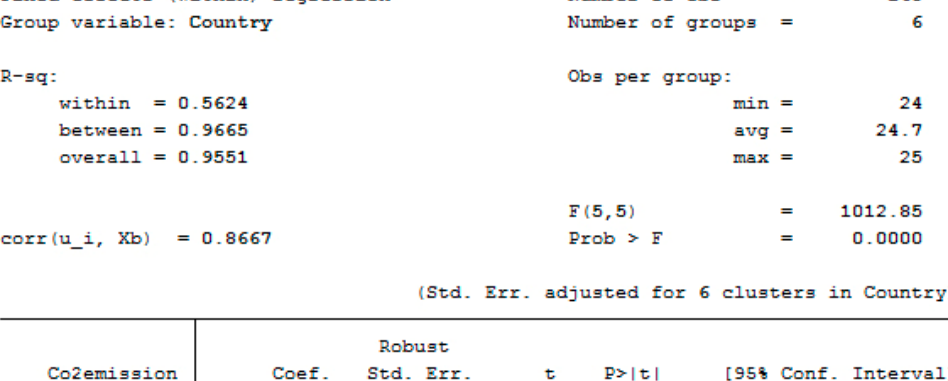
Figure 2. Hausman test for the panel model. Source: Own calculations according to FAOstat data [27]. Standard diagnostics of the Hausman test indicated that, for values < 5%, an analysis of the